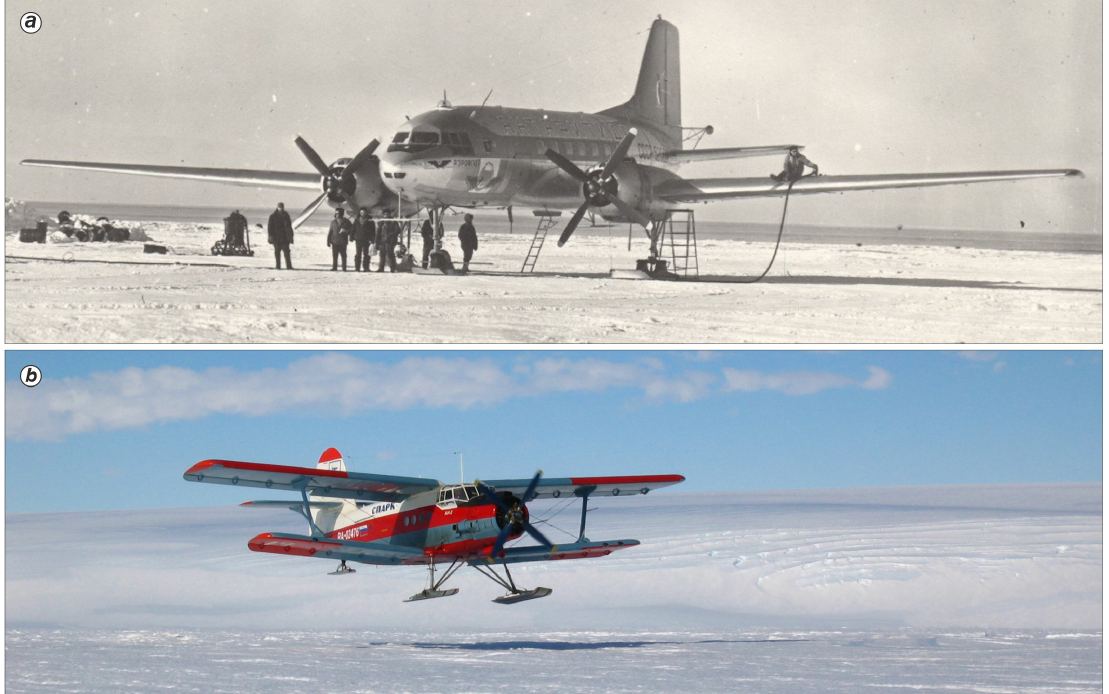
Figure 2. Russian (Soviet) survey airplanes: ( a ) Ilyushin aircraft IL-14 and ( b ) Antonov aircraft An-2. Photos from the PMGE